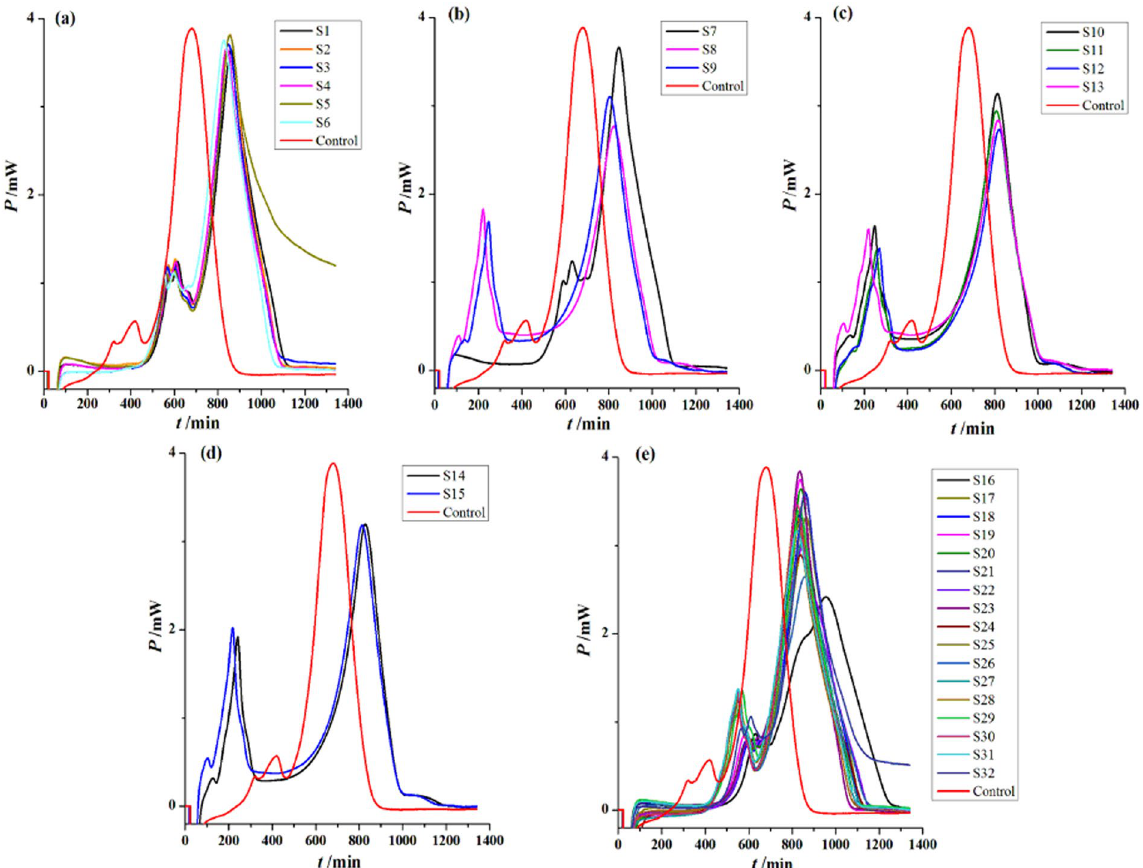
Figure 4. The power-time curves of P . aeruginosa growth at 37 °C affected by S . miltiorrhizae extracts from different sources. Samples are from ( a ) Sichuan province, ( b ) Henan province, ( c ) Shandong province, ( d ) Beijing Tongrentang and Hongshengtang Co. Ltd., and ( e ) Guizhou Xinbang Pharmaceutical Co.